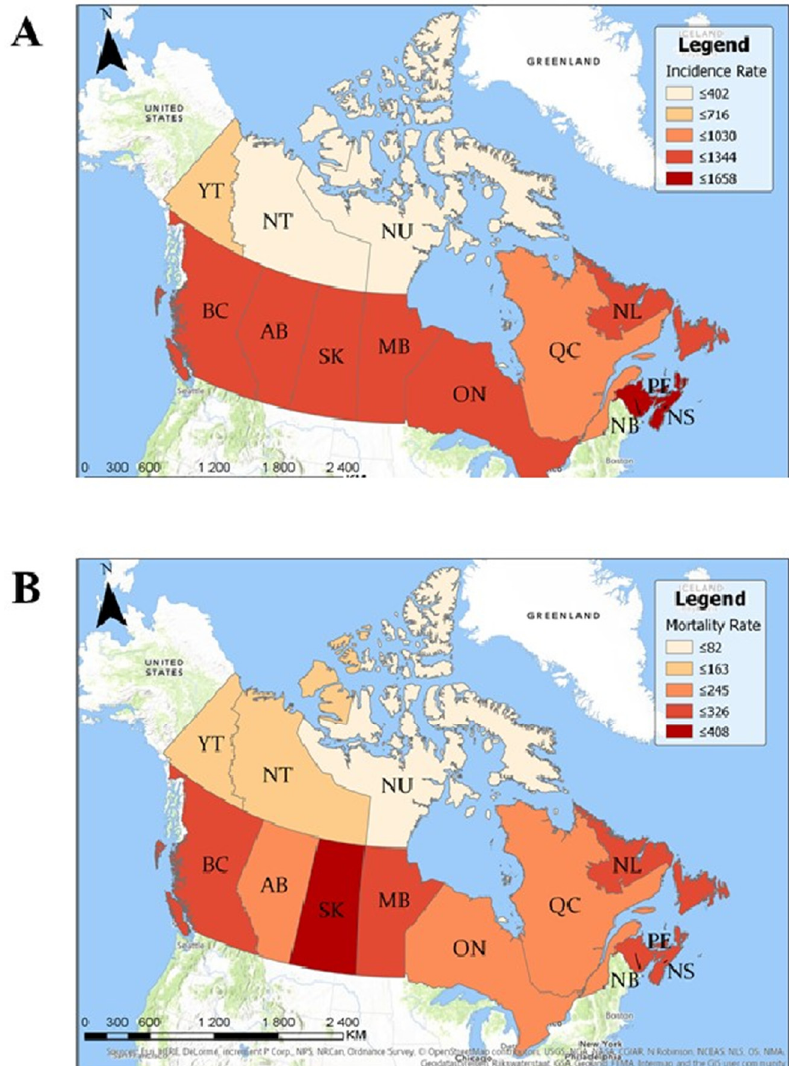
Figure 2. Geographic map of prostate cancer incidence and mortality rates per 1,000,000 men per year by province. ( A ) Rates of prostate cancer incidence per 1 million men per year by province between 1992 and 2010. Higher incidence rates are represented by darker shades of red / brown. ( B ) Mortality rates of prostate cancer per 1 million men per year by province between 1992 and 2010. Higher mortality rates are represented by darker shades of red/brown.